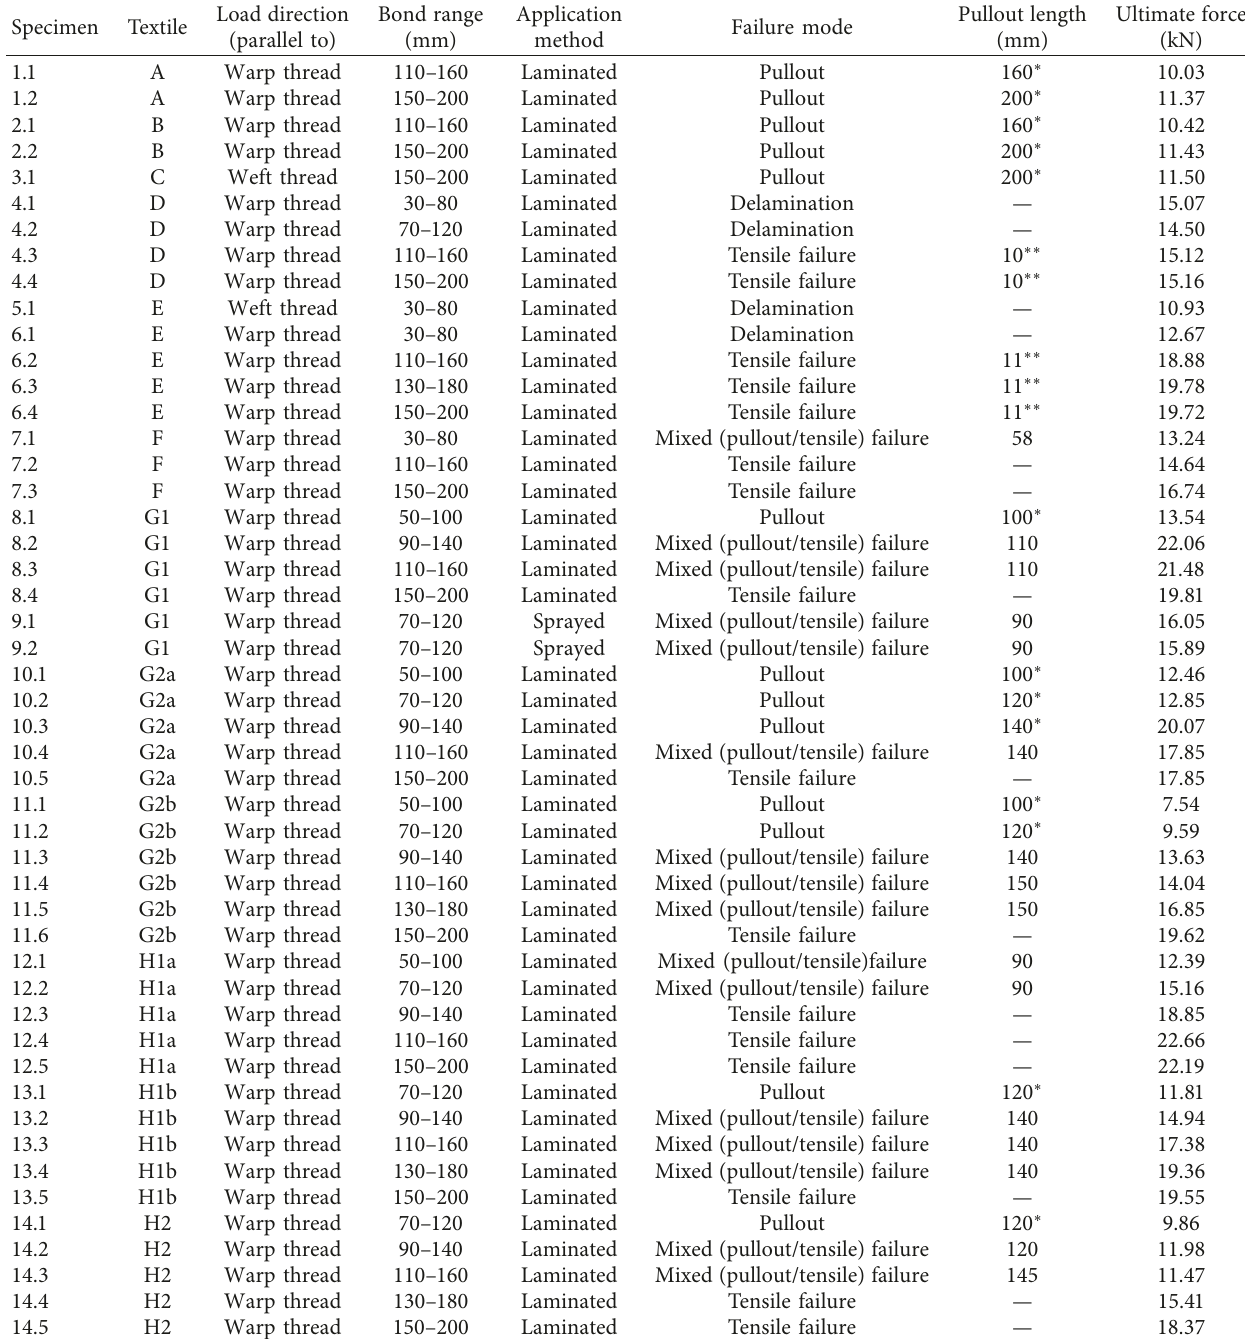
Table 2: Test results of 1st